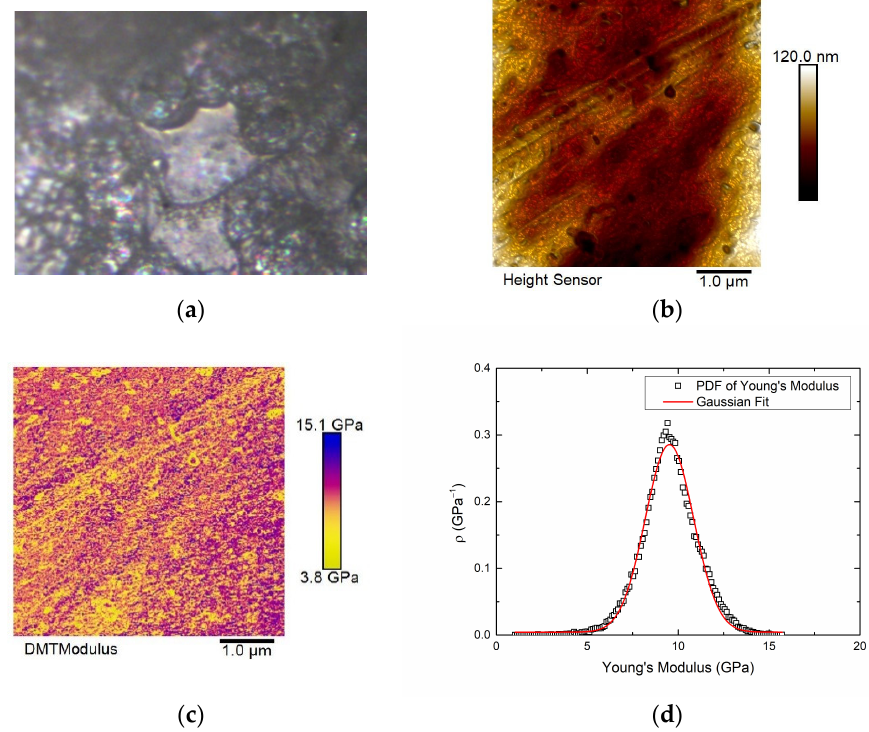
Figure 4. ( a ) Optical photograph of the flat area scanned for nanomechanical and electrical measurements. ( b ) Topography of a region of the sample (5 × 5 um scan). The minimum height data value has been shifted to zero. ( c ) Young’s modulus map of the area scanned in ( b ). ( d ) Probability density function of Young’s modulus values in ( c ).